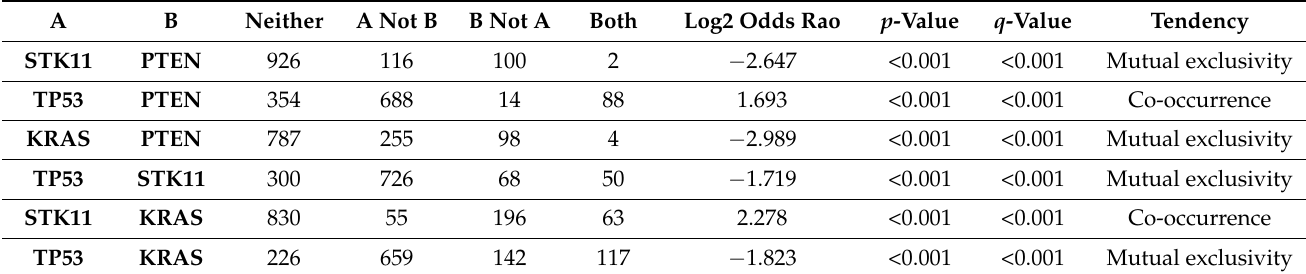
Figure 1. Mutation profile of STK11 , PTEN, KRAS , and TRP53 in human lung cancer. Genomic alterations of STK11 , PTEN , KRAS , and TP53 in The Pan-Lung Cancer gene set by The Cancer Genome Atlas (total n = 1184; adenocarcinoma = 660, squamous cell carcinoma = 484). Data were generated from cBioPortal.org. Table 1. Occurrence of STK11, PTEN, TP53, and KRAS mutations in lung cancer.